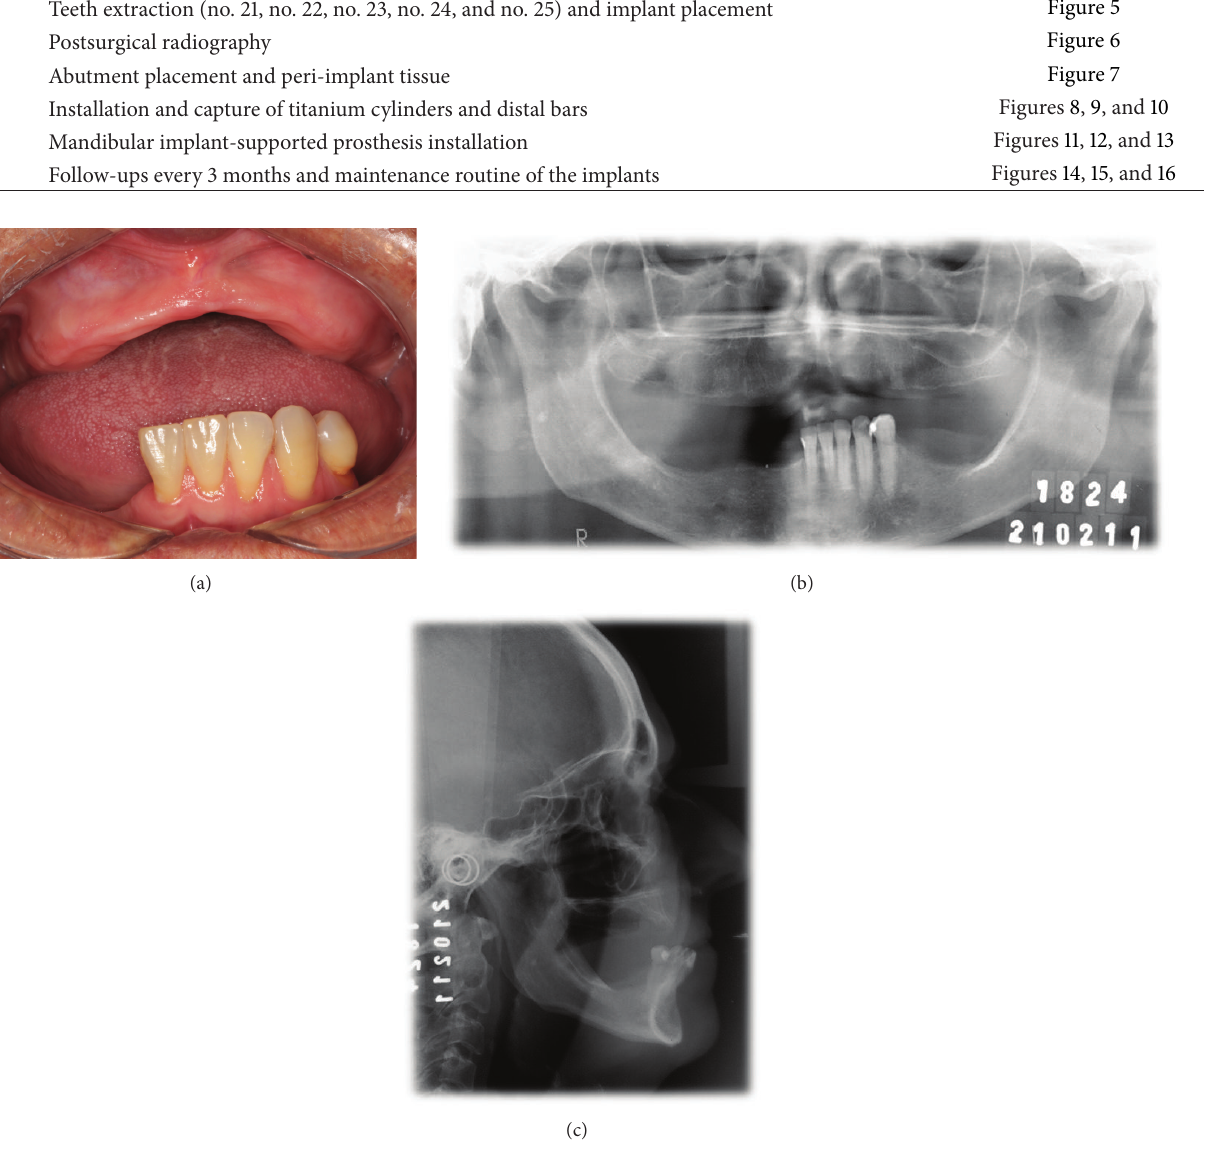
Figure 1: (a) Clinical exam: edentulous maxillary and partially edentulous mandible. (b) Radiographic exam: panoramic radiography. Mandibular height favoring dental installation implants. (c) Radiographic exam: teleradiography. Favorable maxillomandibular relationship to the installation of dental implants and prosthetic rehabilitation